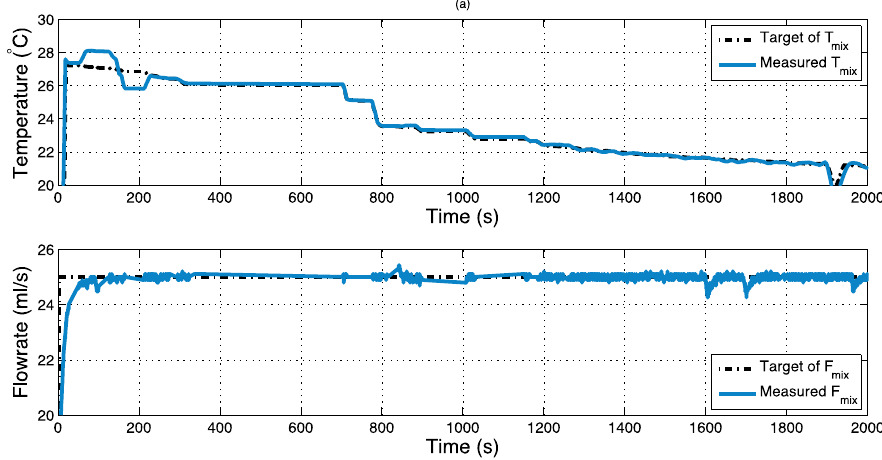
Figure 10. Radiant cooling control